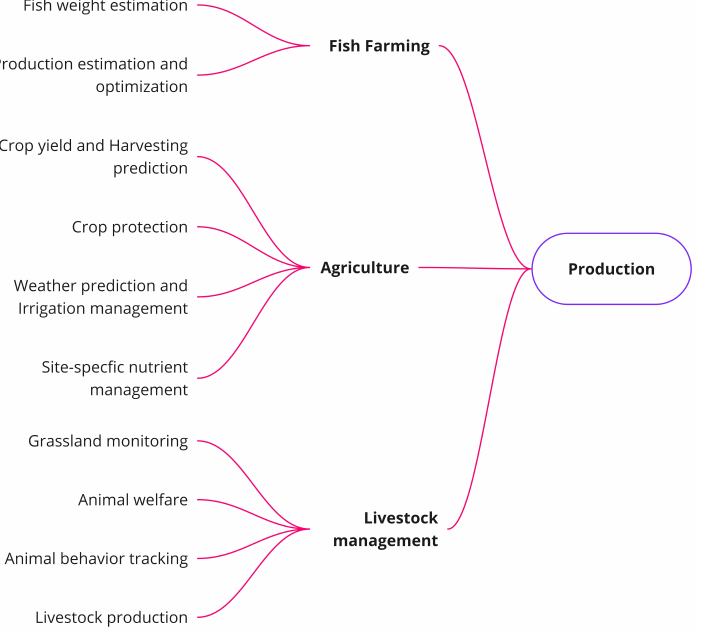
Figure 6. FSC problems in the production